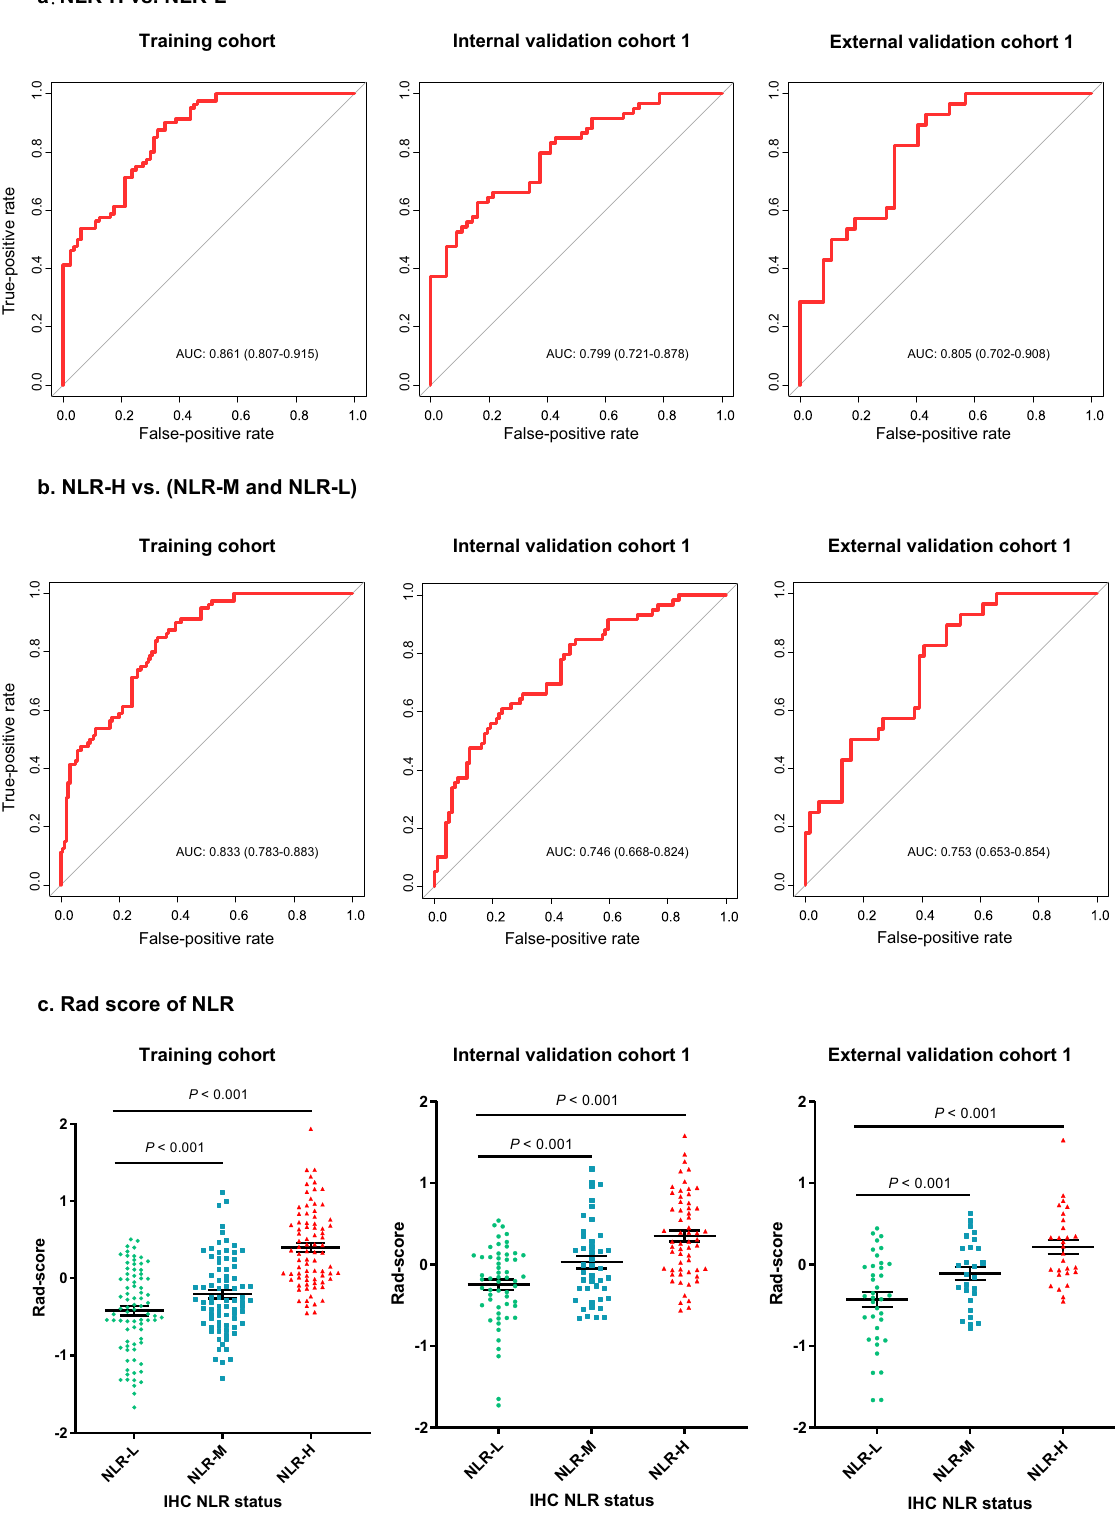
Fig. 3 | Performance of the radiomics imaging biomarker in the training and validation cohorts. a AUCs of the receiver operating characteristic curves of the radiomics imaging biomarker comparing the NLR-H group to the NLR-L group in eachcohort. b AUCsofthereceiveroperatingcharacteristiccurvesoftheradiomics imaging biomarker comparing the NLR-H group to the combination of the NLR-L and NLR-M groups in each cohort. c Radiomics score of different NLR statuses in